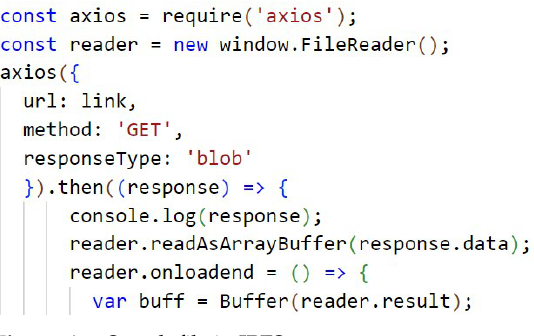
Figure A7. Search file in IPFS.